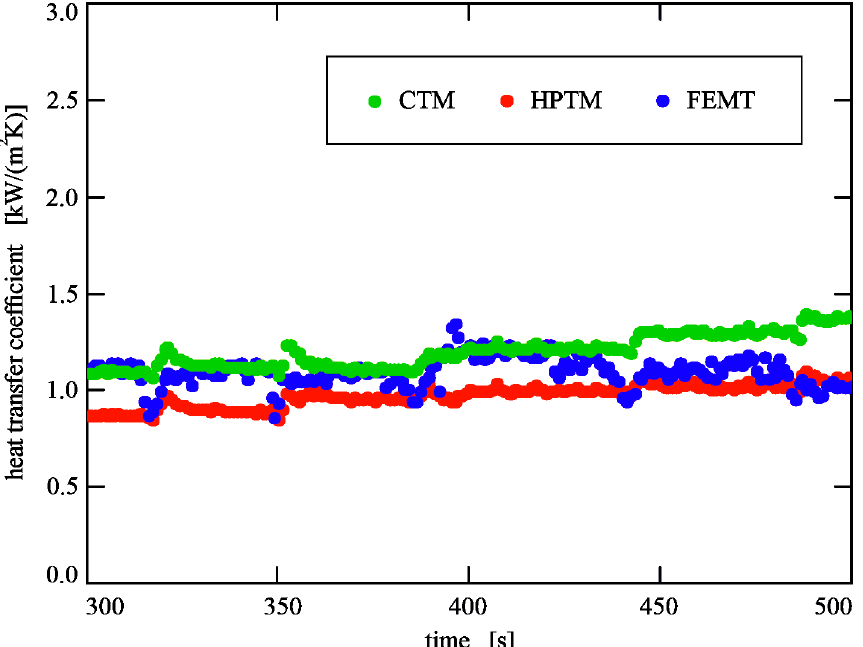
Figure 10. Heat transfer coefficient versus time, the distance from the mini-channel inlet x = 0.0114 m; other experimental parameters are listed in Table 1.